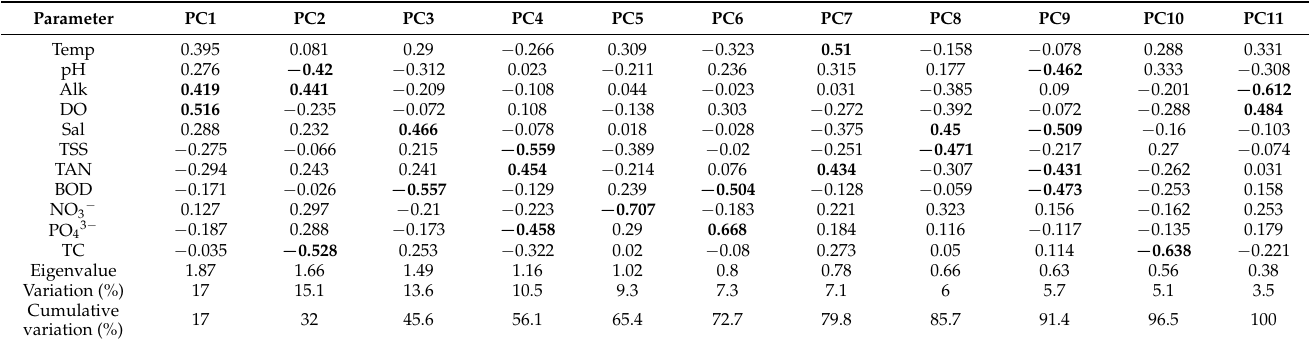
Table 4. Principal component analysis for water quality on the Hau River in 2019.